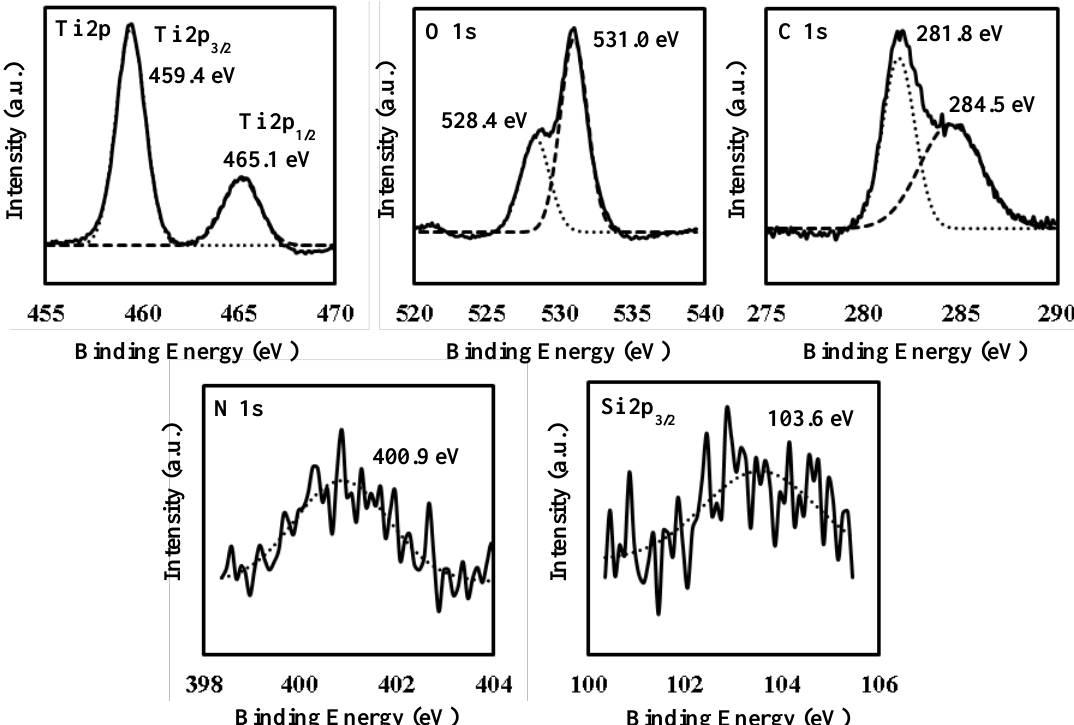
Figure 5. X-ray photoelectron spectroscopy (XPS) spectra of Ti 2p, O 1s, C 1s, N 1s, and Si 2p of surface of F 4 . The solid lines indicate the original data of XPS. The dashed and doted curves indicate theoretically fitted curves by assuming Gaussian distribution.